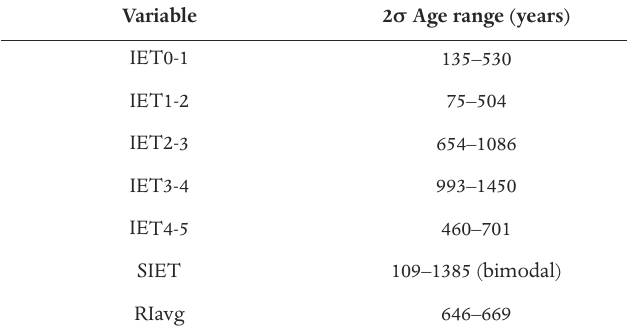
Table 3. Duration between earthquakes derived from the OxCal model (see Figure 9 and electronic supplement 1). Note: IET0-1 is the inter-event time between event 0 and event 1. SIET, summed inter-event time; RIavg, average recurrence